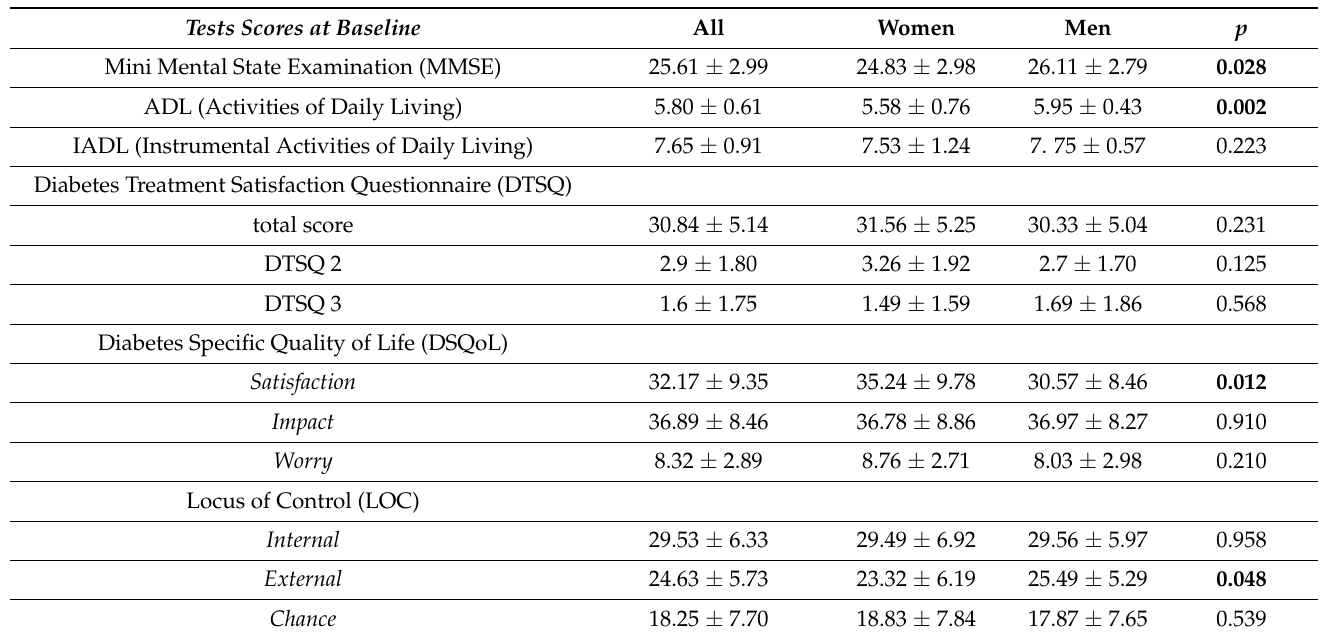
Table 2. Tests scores at baseline in T2D elderly subjects participating to in the study, according to